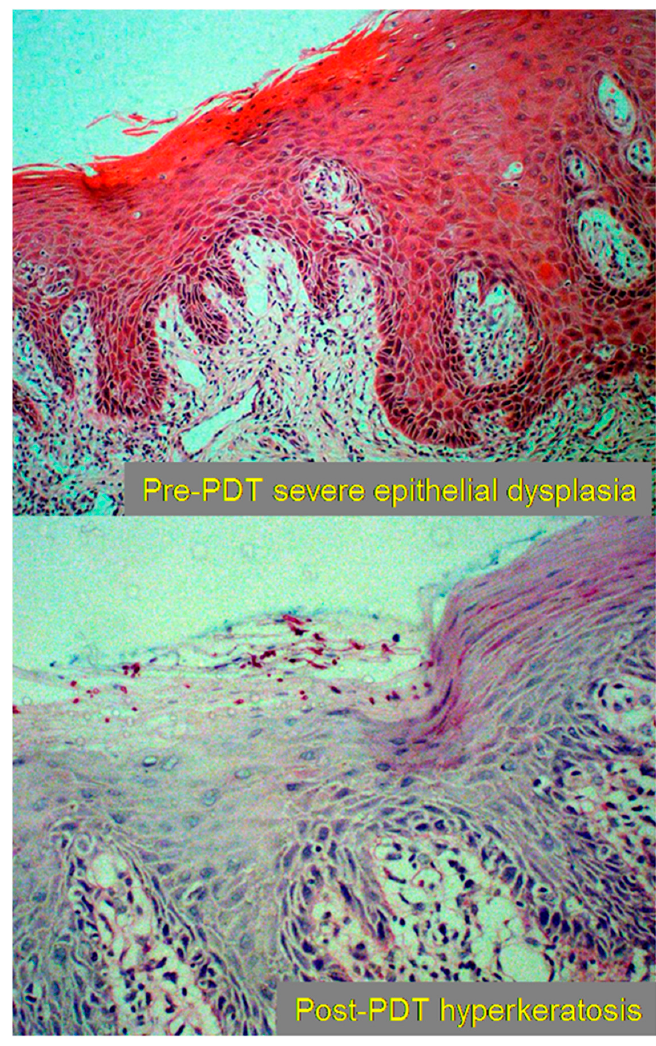
Figure 7. Histopathological slides displaying the replacement of dysplastic tissue pre-PDT with hyperkeratotic tissue post-PDT. Reprinted with permission from ref. [50]. Copyright 2011 Lasers Surg. Med.